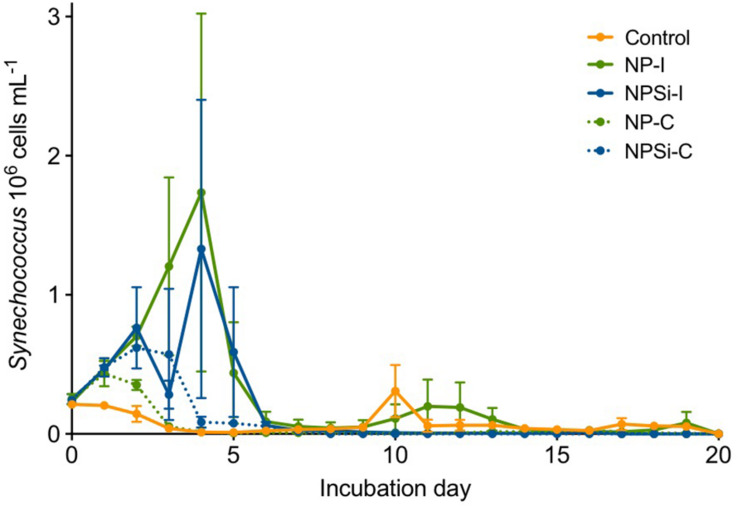
Synechococcus cell abundances (in 106 cells mL–1, ± range) determined along the duration of the experiment for control and nutrient addition treatments (NP-I, initial nitrate and phosphate addition; NPSi-I, initial nitrate, phosphate and silicate addition; NP-C, continuous initial nitrate and phosphate addition; NPSi-C, continuous nitrate, phosphate and silicate addition).